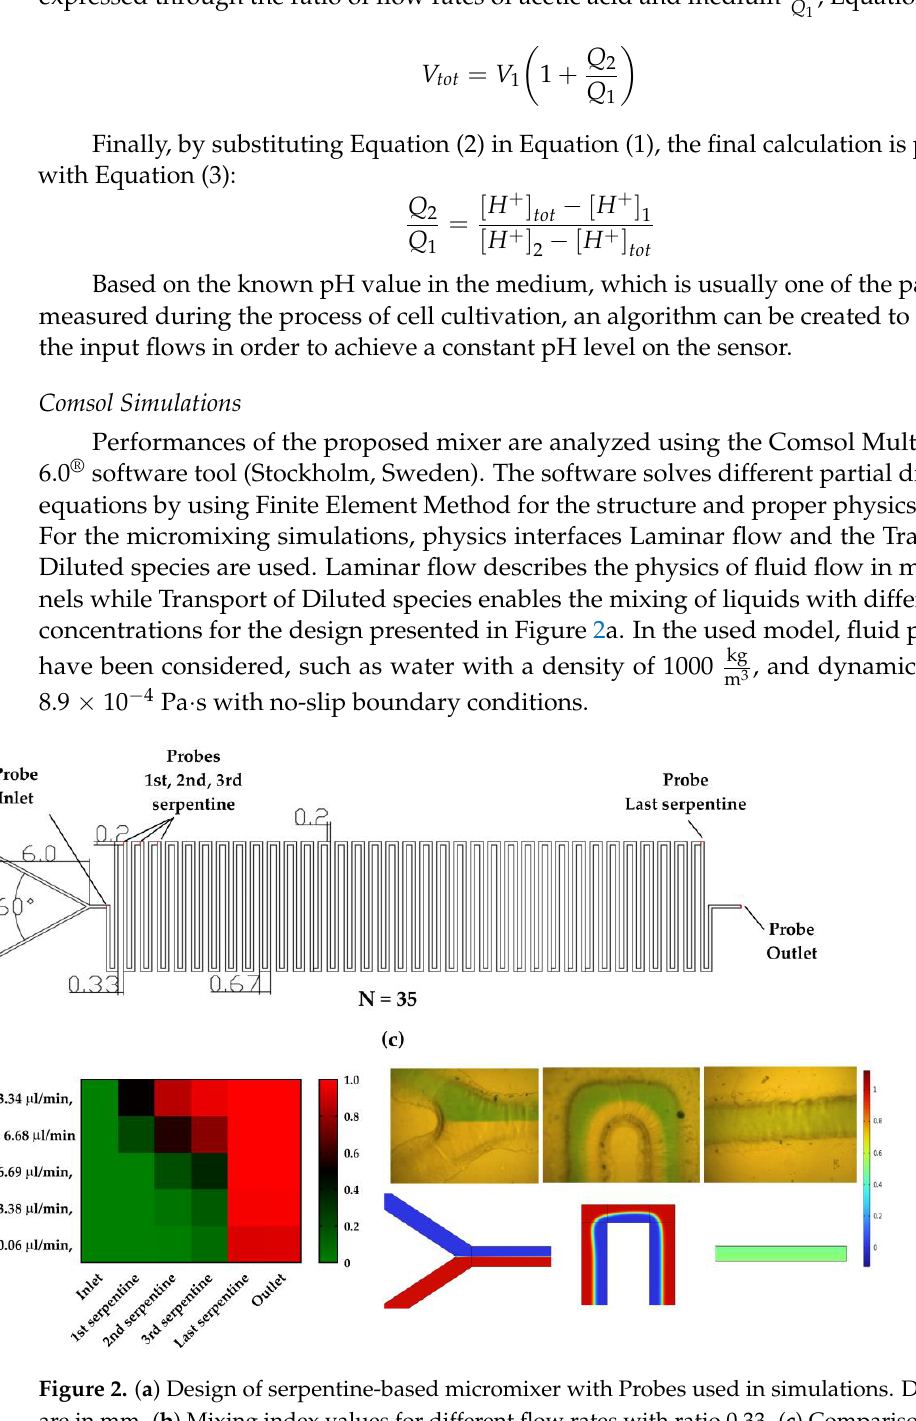
Figure 2b. In general, in the case of low values of flow rate, the dominant mechanism of